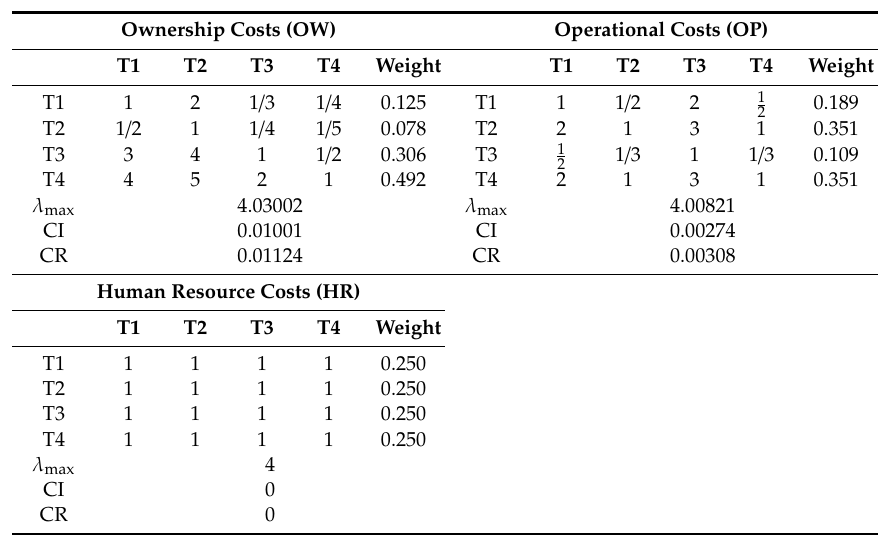
Table 8. Results of the pair-wise comparison of economic sub-criteria: Ownership costs (OW), operational costs (OP), and human resource costs